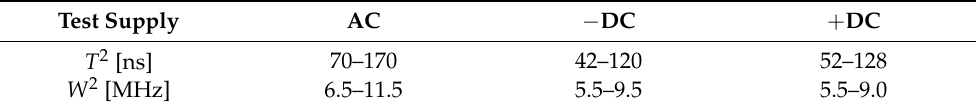
Table 4. Comparison of localized pulse characteristics at the three types of voltage stress.